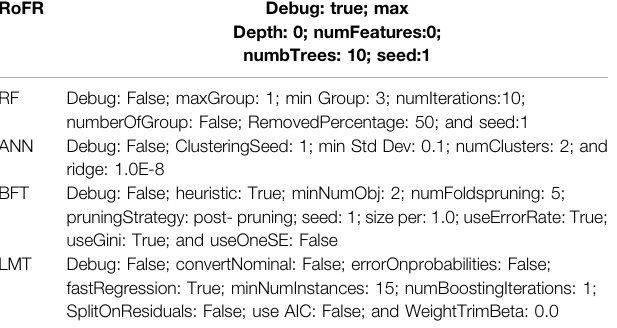
TABLE 5 | Parameters of machine learning algorithms for shallow landslide susceptibility mapping. RoFR